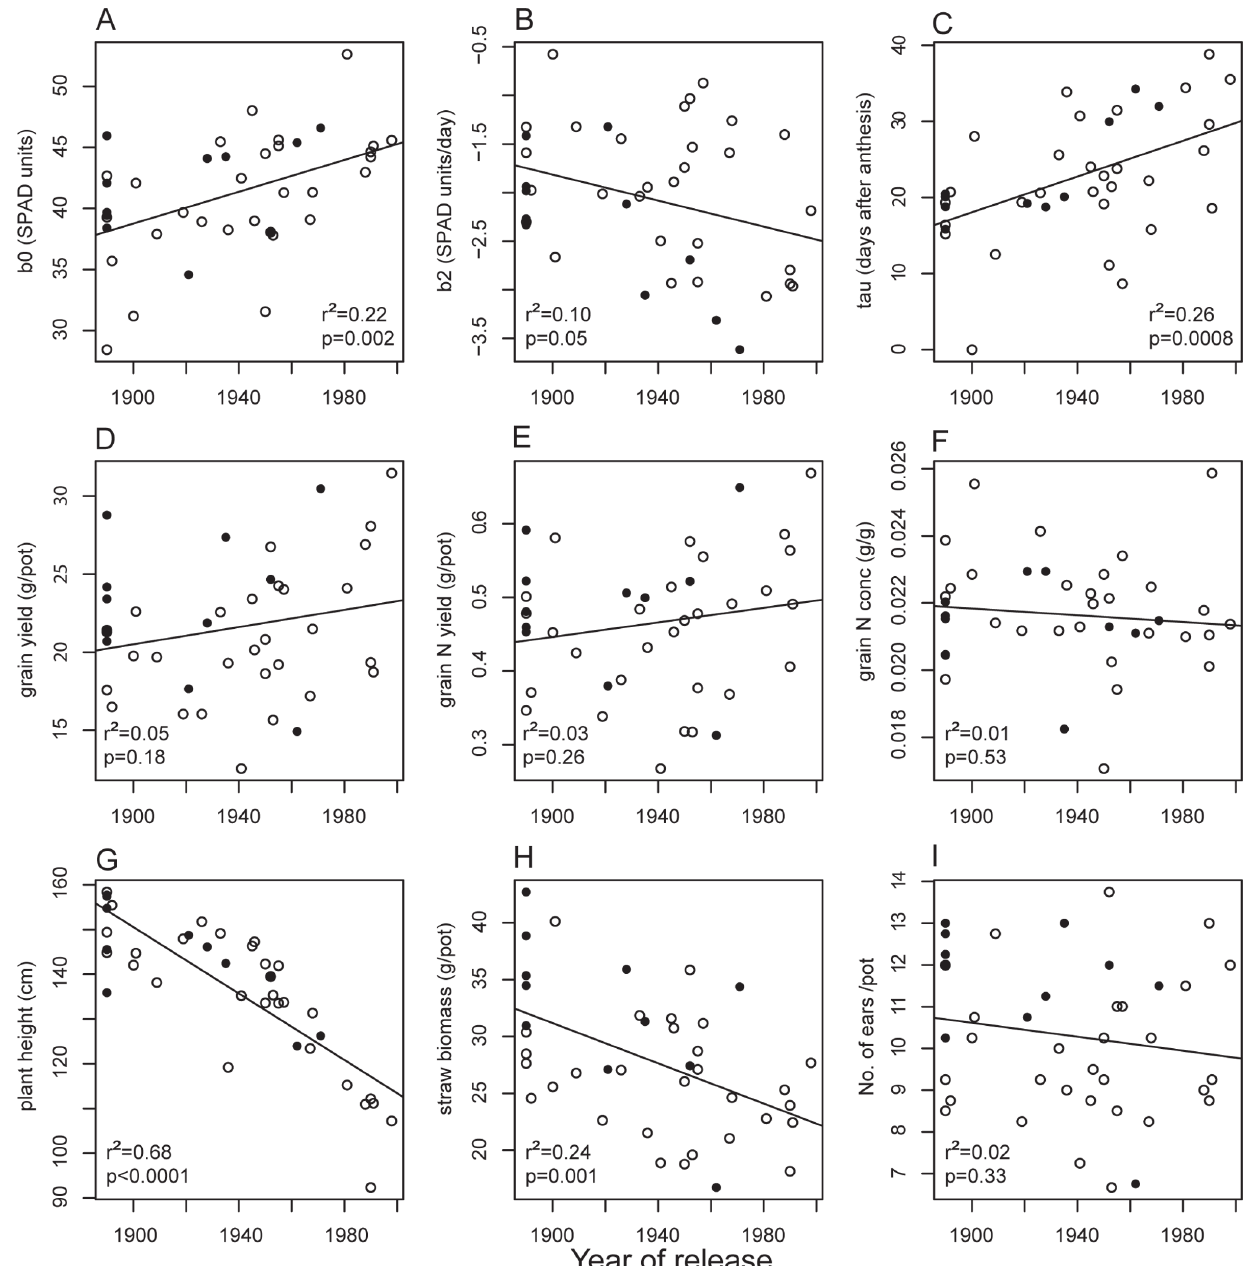
Figure 3. Changes in measured traits over time. Filled circles are varieties with the wildtype allele of NAM-B1 , open circles are varieties with the deletion. A) modeled SPAD-units at anthesis, b 0 , B) rate of senescence, b 2 , C) modeled start of senescence in days after anthesis, t , D) grain yield, E) grain N yield, F) grain N concentration, G) plant height, H) straw biomass, I) number of ears per pot.